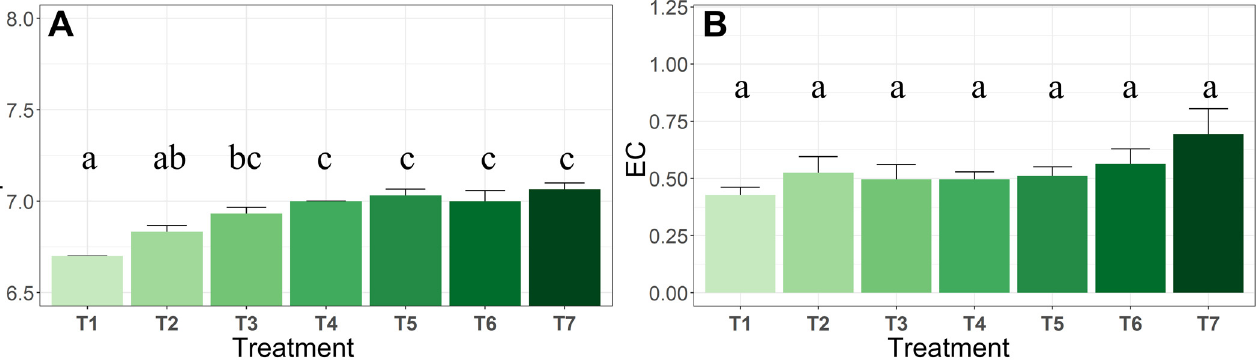
Figure 7. Bar chart of pH ( A ) and EC ( B ) of potting mix with addition of the seven UWP treatments rate (T1 = 0.3%; T2 = 0.5%; T3 = 0.8%; T4 = 1%; T5 = 2%; T6 = 3%; T7 = 5%) at the end of the trial. Error bars denote averages of three replicates per each treatment. For each treatment (bar) different letters show significant differences ( p < 0.05) among means by post hoc Tukey HSD Test.